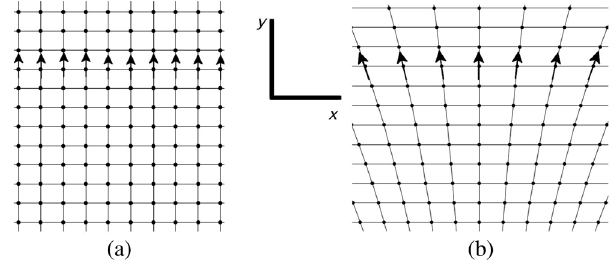
FIG. 3. Cartoon of the polarization response of an (a) unstrained ≠ 0 square lattice and (b) sheared square lattice. In (b), F y ¯ x because motion along the y lattice vector leads to translation in the unstrained x direction. The directed lines are the flow of P charge due to a positive ∂ ; the polarization is measured along t y the lattice vector, which is deformed in (b) because of strain. Only case (b) has a nonzero current in the x direction, which is due to this